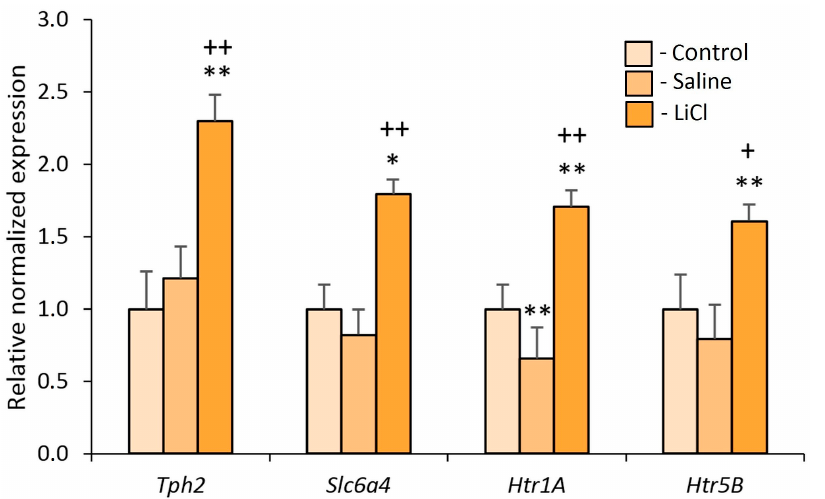
Figure 6. The influence of chronic LiCl treatment on serotonergic gene expression in midbrain raphe nuclei of defeated mice. The measurement data were processed in the Bio-Rad Amplifier software (USA). Bars: the control ( n = 9); Saline - Sal-treated losers ( n = 7); LiCl - LiCl-treated losers ( n = 9). * p < 0.05 and ** p < 0.01 vs. controls, and + p < 0.05 and ++ p < 0.01 vs. Sal-treated losers according to Student’s t -test. The data are presented as mean ± SEM.